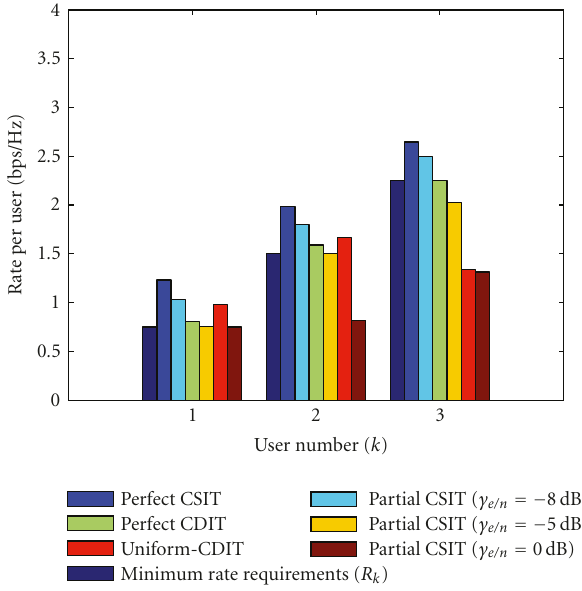
Figure 2: Users rates for di ff erent resource allocation schemes, mean SNR of 15dB and fairness parameter α f = 0.